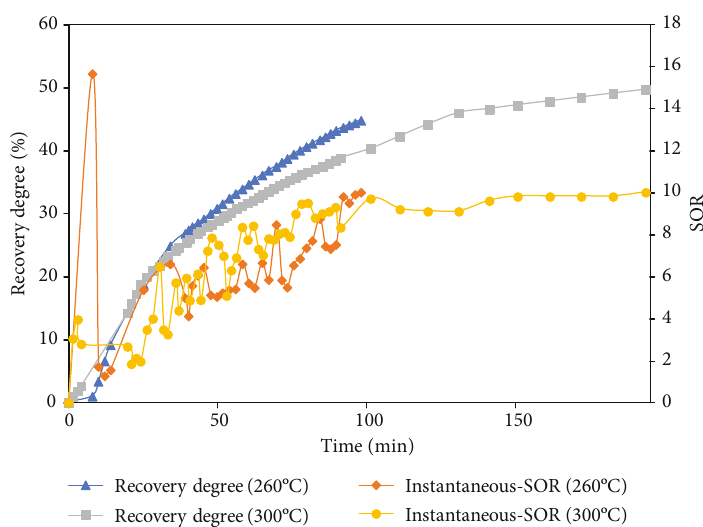
Figure 13: Comparison of superheated SAGD (260 ° C) and superheated SAGD (300 °